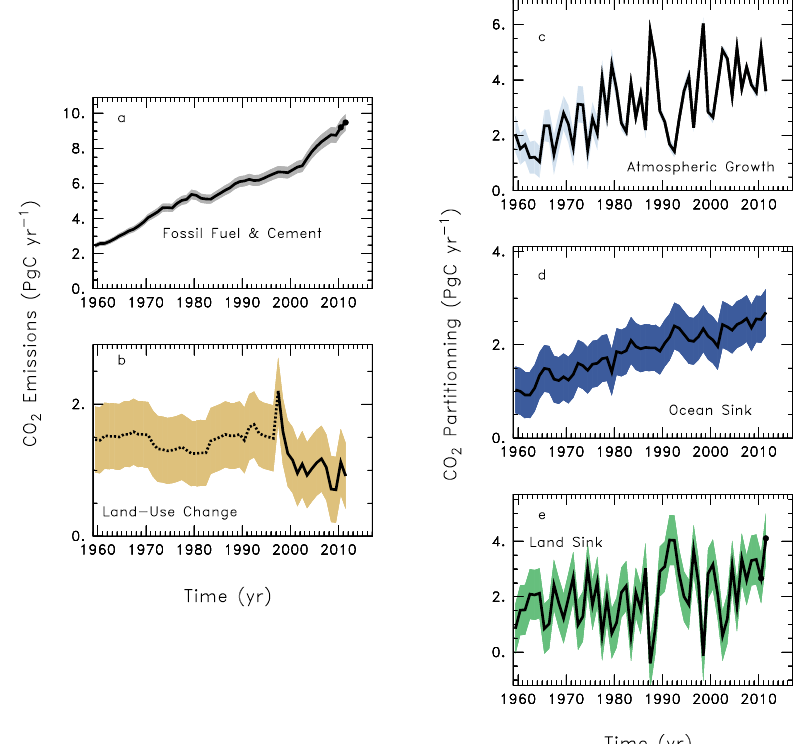
Figure 3. Components of the global carbon budget and their uncertainties as a function of time, presented individually for (a) emissions from fossil fuel combustion and cement production ( E FF ), (b) emissions from land-use change ( E LUC ) with management–climate interactions based on fire activities in deforested areas (full line) or not (dashed line), (c) atmospheric CO 2 growth rate ( G ATM ), (d) the ocean CO 2 sink ( S OCEAN , positive indicates a flux from the atmosphere to the ocean), and (e) the land CO 2 sink ( S LAND , positive indicates a flux from the atmosphere to the land). All time series are inPgCyr − 1 with the uncertainty bounds representing ± 1 sigma in shaded colour. The black dots in panels (a) and (e) show the values based on emissions extrapolated using BP energy